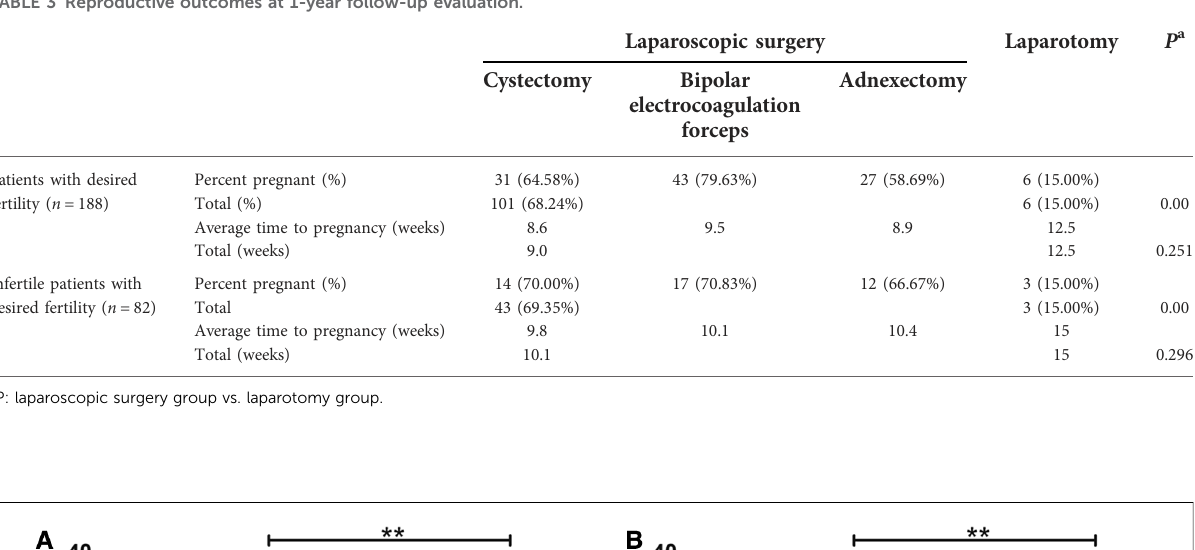
TABLE 3 Reproductive outcomes at 1-year follow-up evaluation.